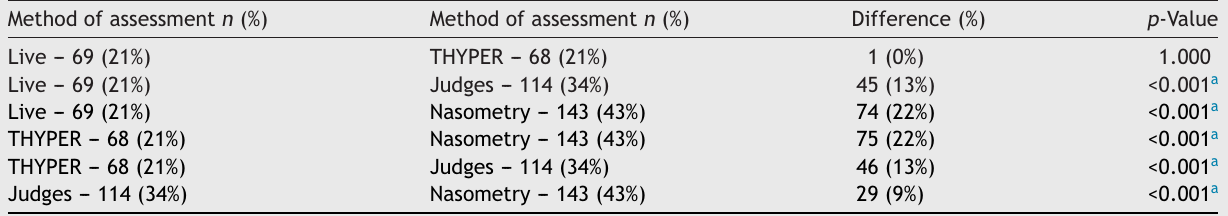
Number and percentage of patients with hypernasality, according to the four methods of assessment and difference between findings and p